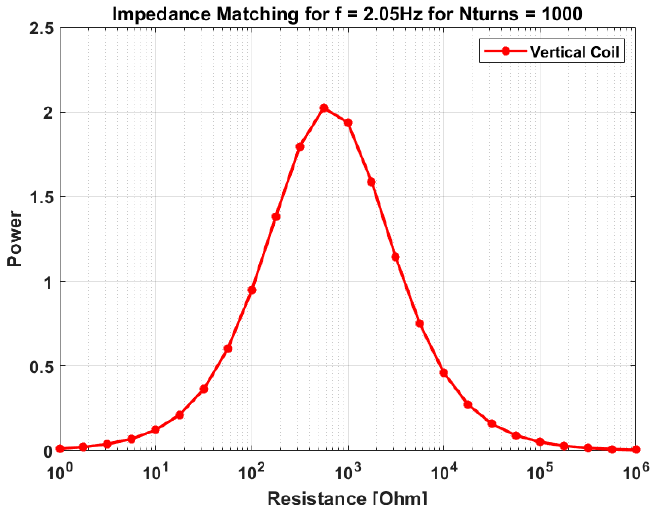
Figure 9. Impedance matching for Vertical coil of 1000 turns on L = 10 cm tank for frequency = 2.05 Hz.